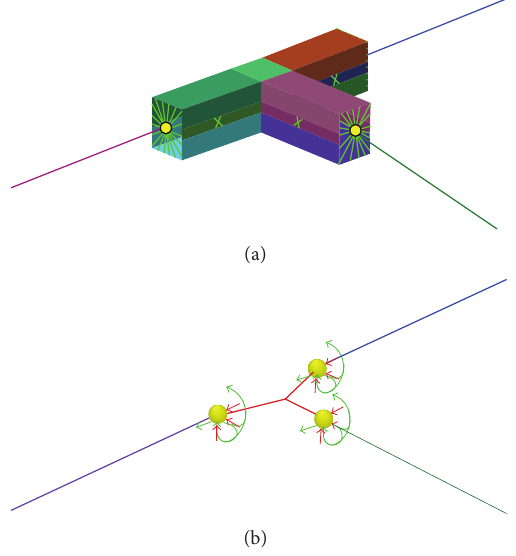
Figure 8: Concept model: before (a) and after (b) the reduction of joint in SE. The three master nodes of SE are in